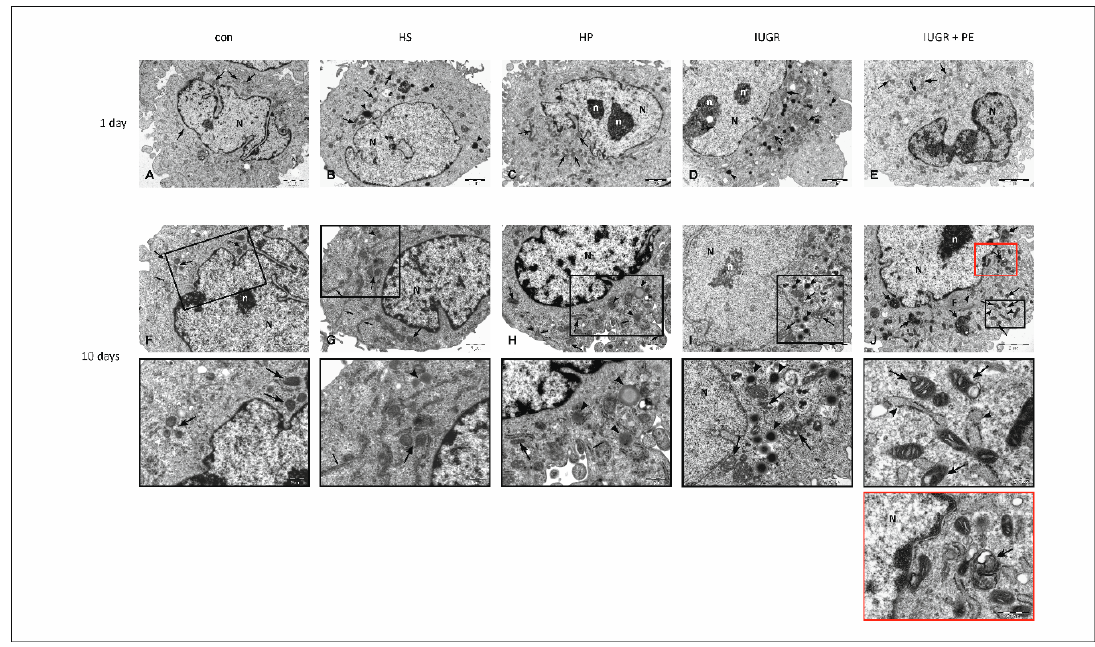
Figure 5. Electron micrographs of EA.hy926 cell line after one (panels A–E) and 10 (panels F–J)